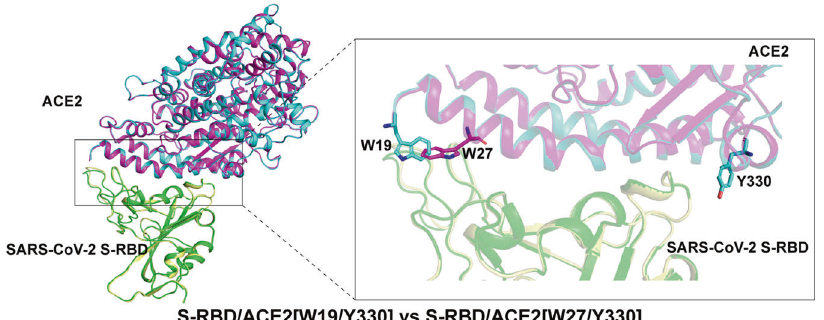
Fig. 4 Steric con fl icts between W19 and W27 in ACE2 when engaging SARS-CoV-2 S-RBD. The S-RBD/ACE2[W19/Y330] (S-RBD in green and ACE2 in cyan) and S-RBD/ACE2[W27/Y330] (S-RBD in light yellow and ACE2 in magenta) complex structures solved in this study are superimposed onto each other and presented in the left panel. A magni fi ed view of the S-RBD/ACE2-binding interface is highlighted in the right panel. The interface-located residues W19, W27, and Y330 are shown and